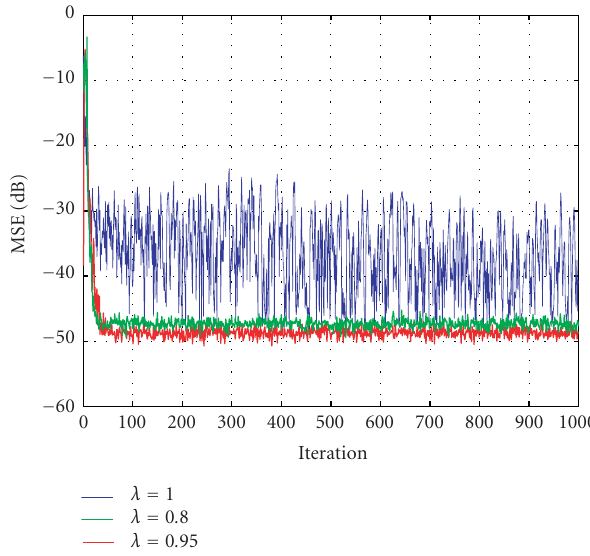
Figure 8: Learning curve for the standard extended lattice recur- sions quantized in 16 bits for di ff erent values of λ and for an order-5